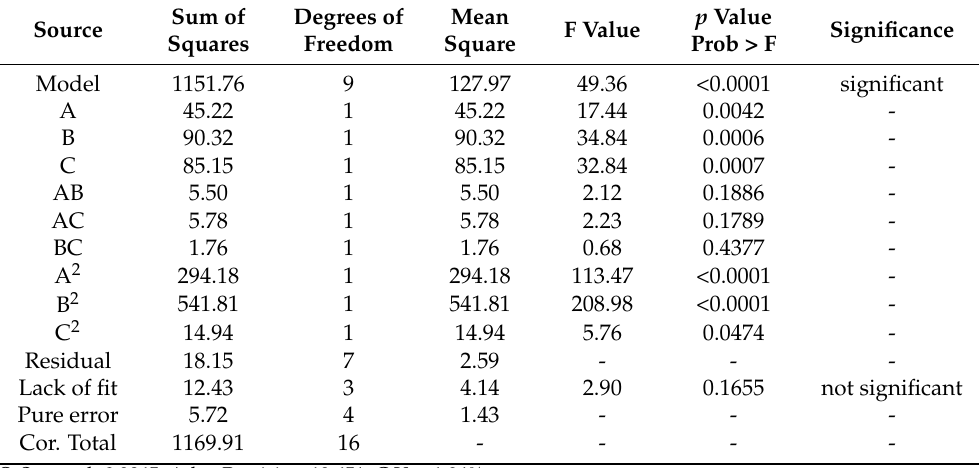
8 of 17 p Value<break Significance />Prob > F Significance